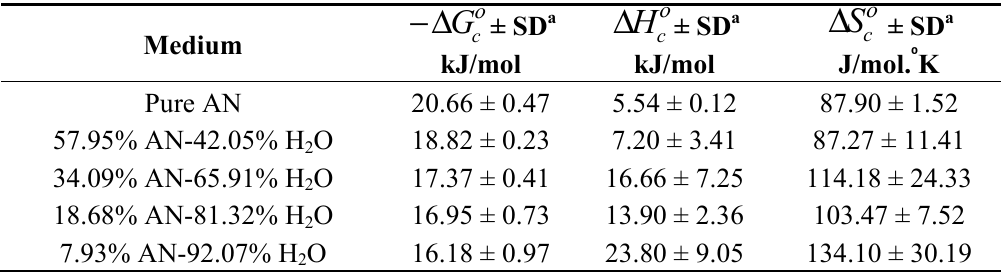
Table 2. Thermodynamic parameters for different CMCR-Ti(OH)(OH O binary various AN–H 2